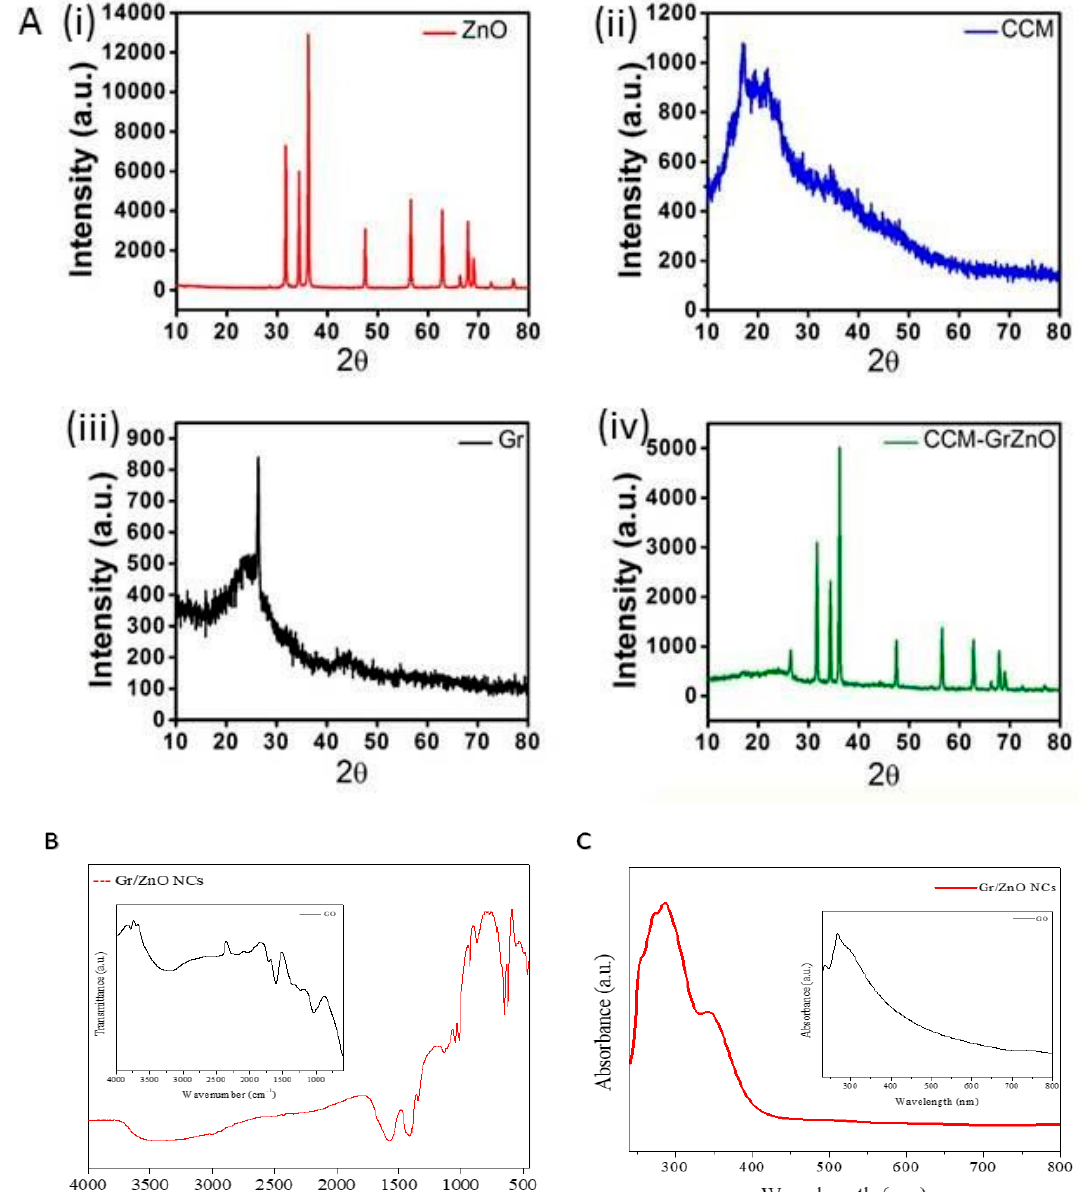
Figure 2. GrZnO-NCs structural characterizations ( A ) XRD patterns of N.P.s were recorded with a 2 θ angle in the range of 20–80. XRD pattern of N.C.s showed well-resolved crystalline diffraction peaks. Inset corresponds to the XRD pattern observed for the G.O. sheet. ( B ) Representative FTIR spectrum of the synthesized GrZnO-NCs. The inset represents FTIR for G.O. ( C ) U.V.–visible absorption spectrum of GrZnO-NCs, inset represents spectrum for G.O.